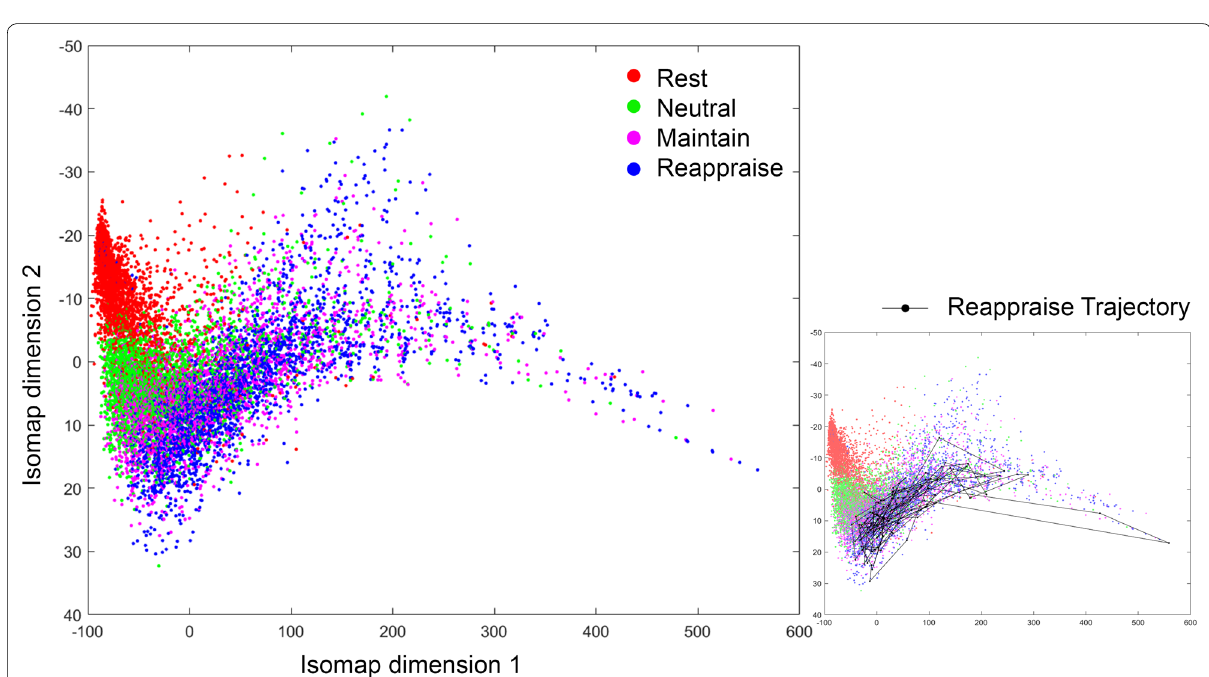
Fig. 3 An example Thought Chart using NDR method of ε -isomap, Thought Chart follows the same ordered transition of resting, Neutral , Maintain